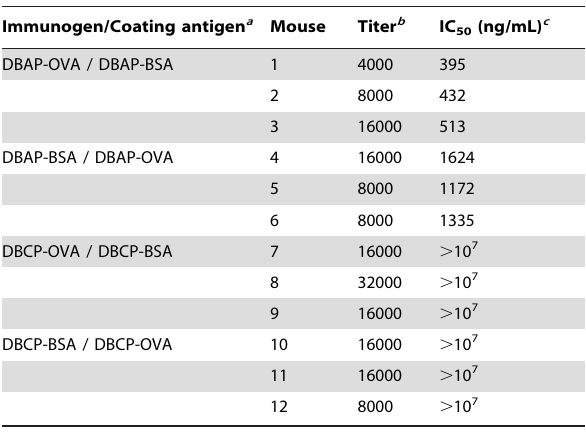
Table 1. Titers and sensitivity of antisera of immunized mice.